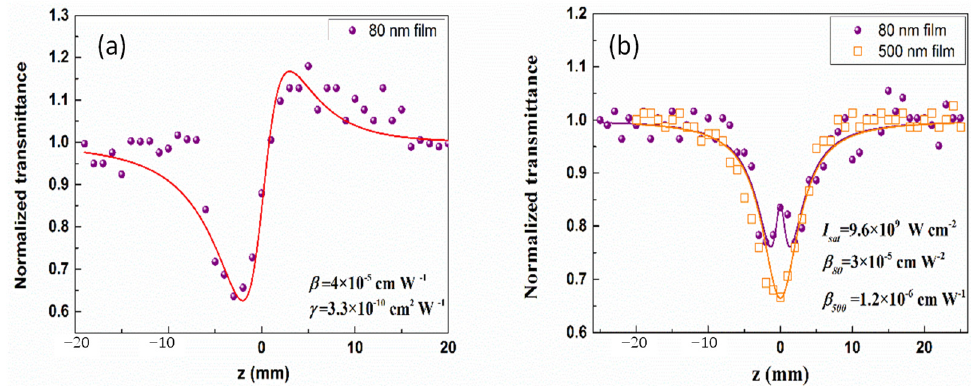
Figure 4. Normalized transmittances in the case of ( a ) CA Z-scan of 80 nm film and ( b ) OA Z-scans of 80 nm and 500 nm films measured using the 400 nm, 35 fs pulses. Theoretical curves are the fits using Z-scan theory. Reprinted with permission from Ref. [25], 2019, Walter de Gruyter GmbH & Science Wise Publishing.